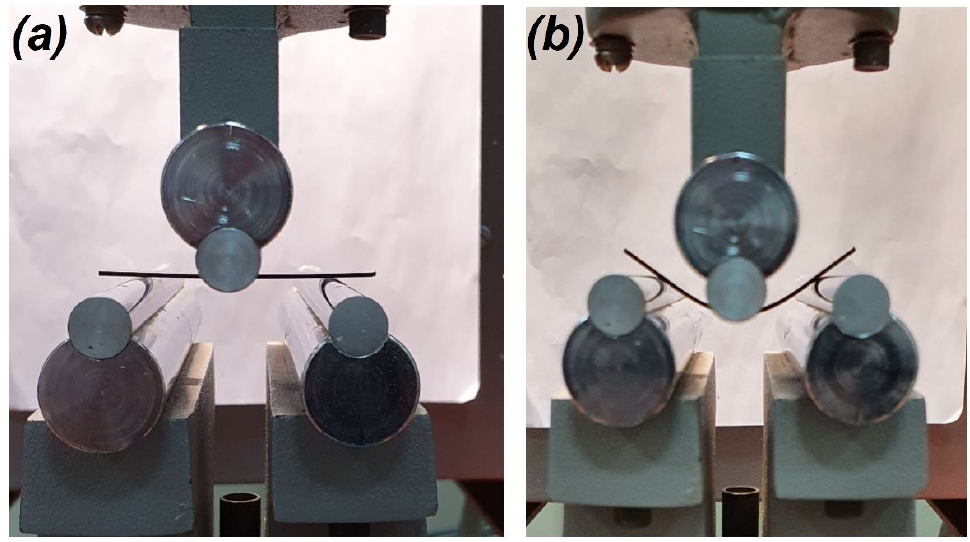
Figure 4. Composite sample before ( a ) and after ( b ) three-point bending